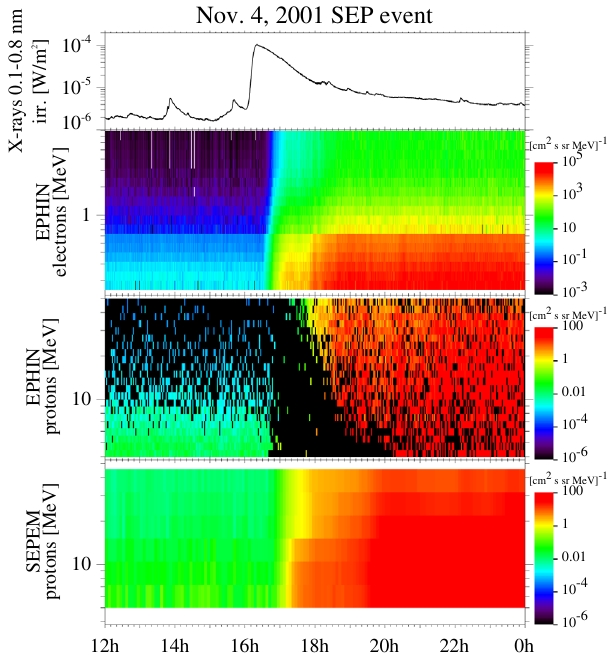
Fig. 8. Solar energetic particle event onset, observed over 12 h on Nov. 4, 2001 by GOES and SOHO. The top panel shows the GOES/ SXT low-energy X-ray fl ux. The second panel from top shows a spectrogram of energetic electrons in the 0.25 – 10 MeV range observed by SOHO/COSTEP-EPHIN. Below that is displayed a 4 – 50 MeV proton spectrograms observed by EPHIN, and at the bottom the SEPEM energy channels of GOES-8/SEM displayed as a spectrogram. Only energy channels with full overlap between GOES 8/SEM and EPHIN are